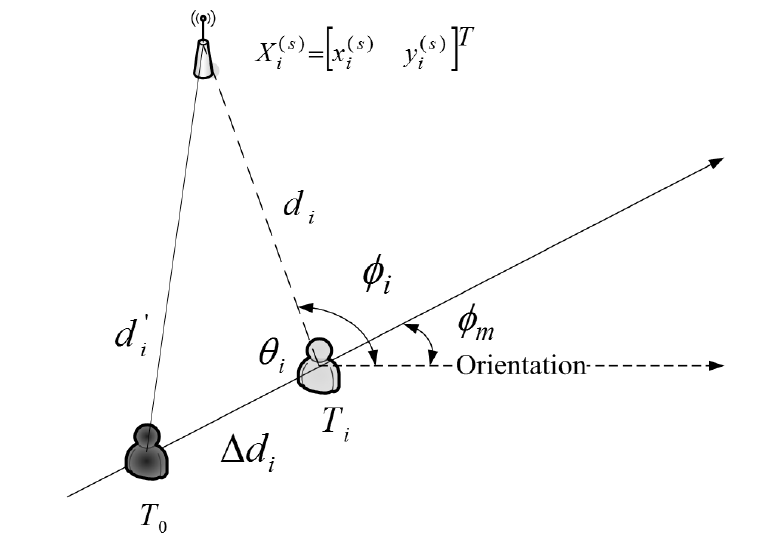
Figure 3. The concept of measurement